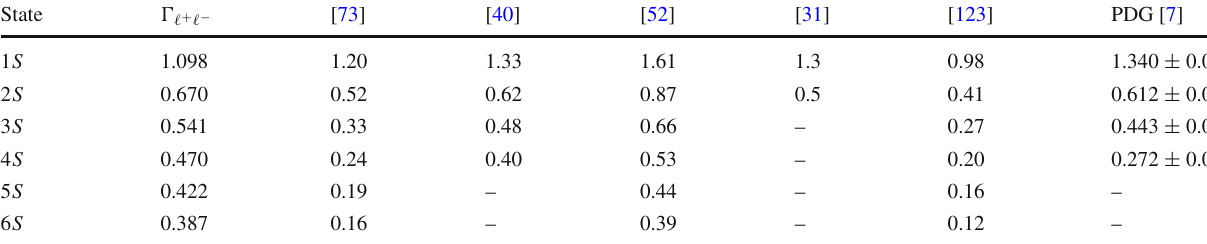
Table 19 Dilepton decay width of bottomonia (in keV)